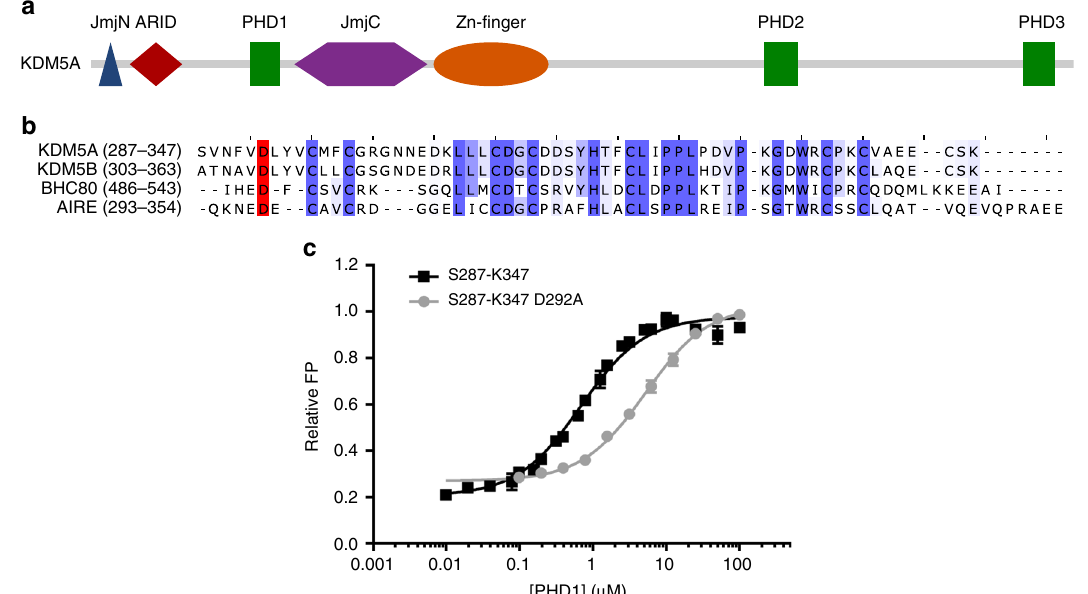
Fig. 1 Asp292 is important for PHD1 binding to H3 N-terminal peptides. a Domain structure of KDM5A. b Sequence alignment of several PHD domains that preferentially bind unmethylated H3K4 peptides. The conserved Asp residues are highlighted in red. Other residues conserved between the different PHD domains are highlighted in blue. c Normalized fl uorescence polarization of 5-carboxy fl uorescein (5-FAM) conjugated H3 10mer peptide binding to PHD1 and PHD1 D292A. Data were fi tted to equation 1 or 2 and binding parameters are shown in Table 1. Errors ( n ≥ 3) represent